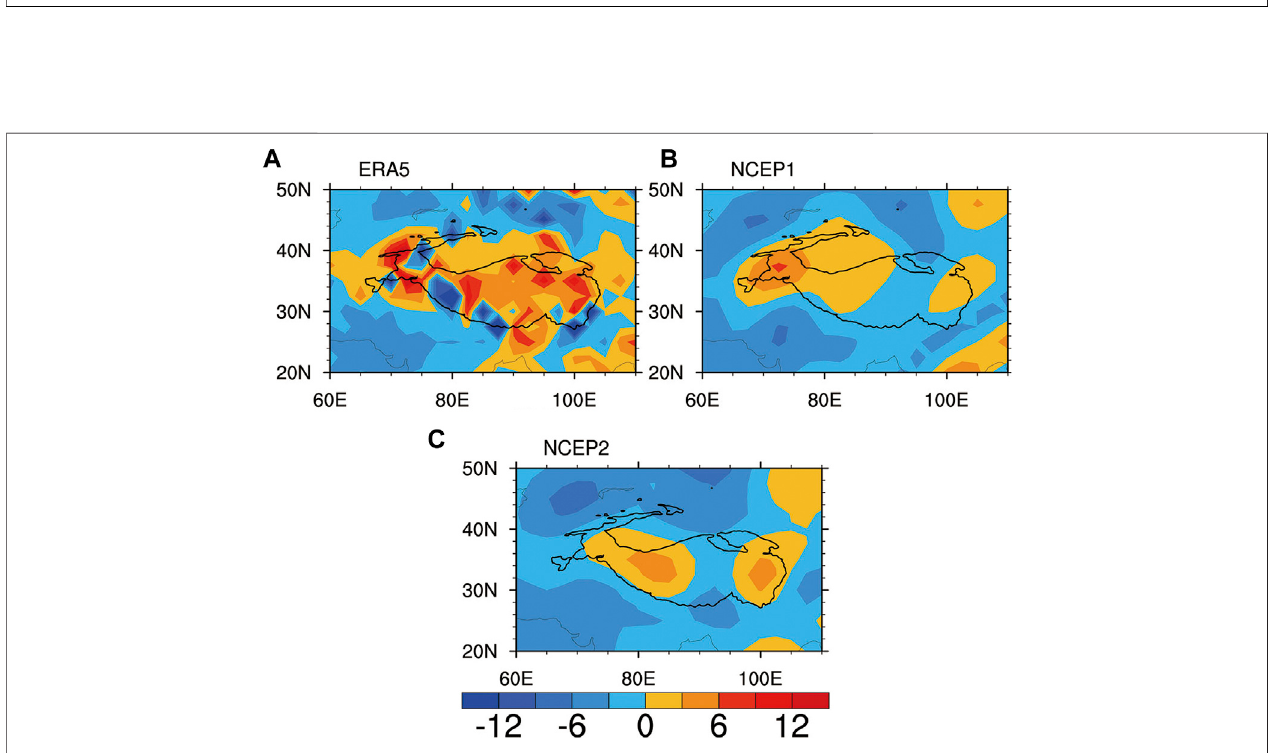
FIGURE 2 | Climatology of the vertically integrated (from 500 to 100 hPa) atmospheric apparent heat source in spring (color shading; units: W m − 2 ) over the QTP and its surrounding areas from 1979 to 2020 based the three reanalysis datasets: (A) ERA5, (B) NCEP1 and (C) NCEP2. The black lines represent the 3,000 m altitude